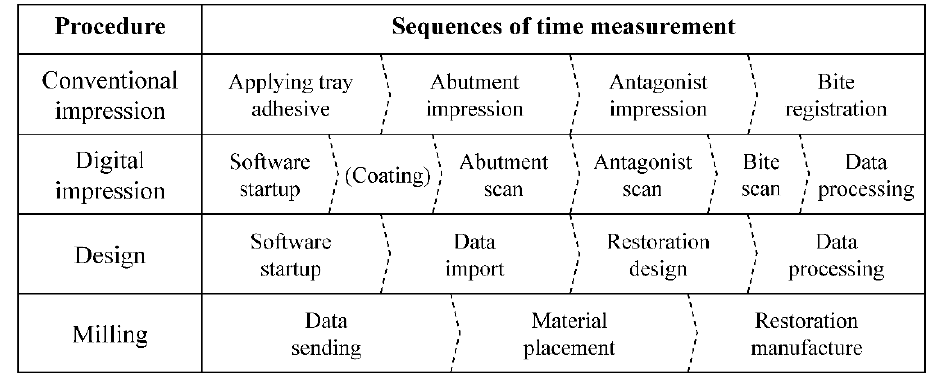
Figure 3. Specific steps in the procedure for time measurement.